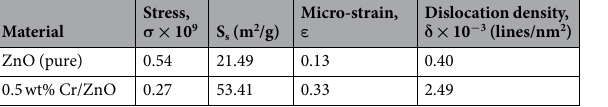
Table 3. The In-plane stress ( σ ), the specific surface area (S s ), the micro-strain ( ε ) and dislocation density ( δ ) for the ZnO (pure) and 0.5 wt% Cr/ZnO